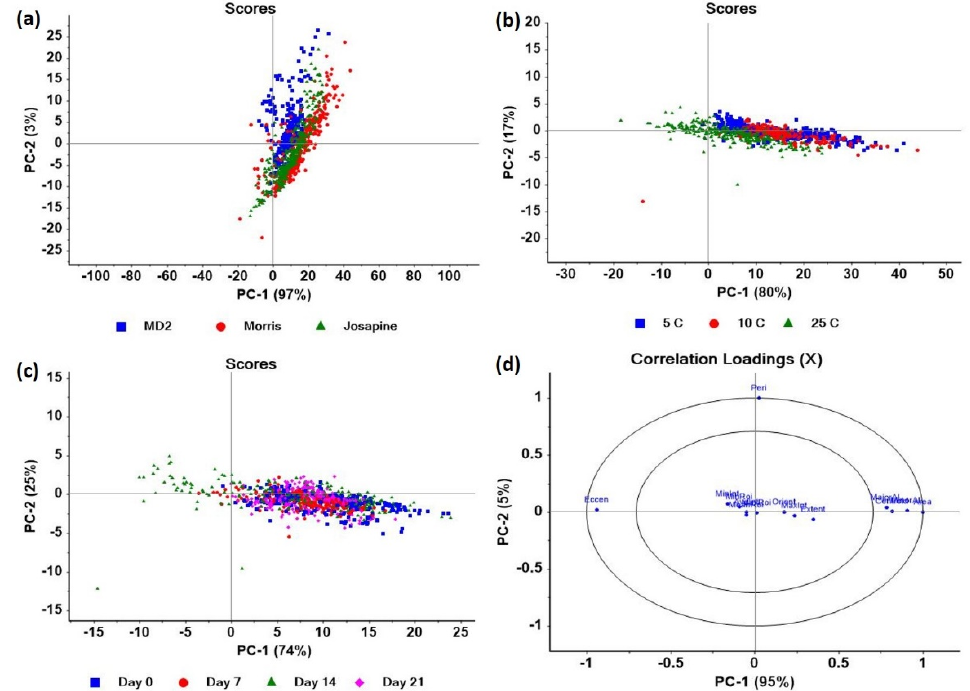
Figure 5. Principal component analysis score plots showing the variation of image parameters based on: ( a ) fruit cultivars, ( b ) storage temperatures, ( c ) storage days, and ( d ) correlation loading plot of image parameters.